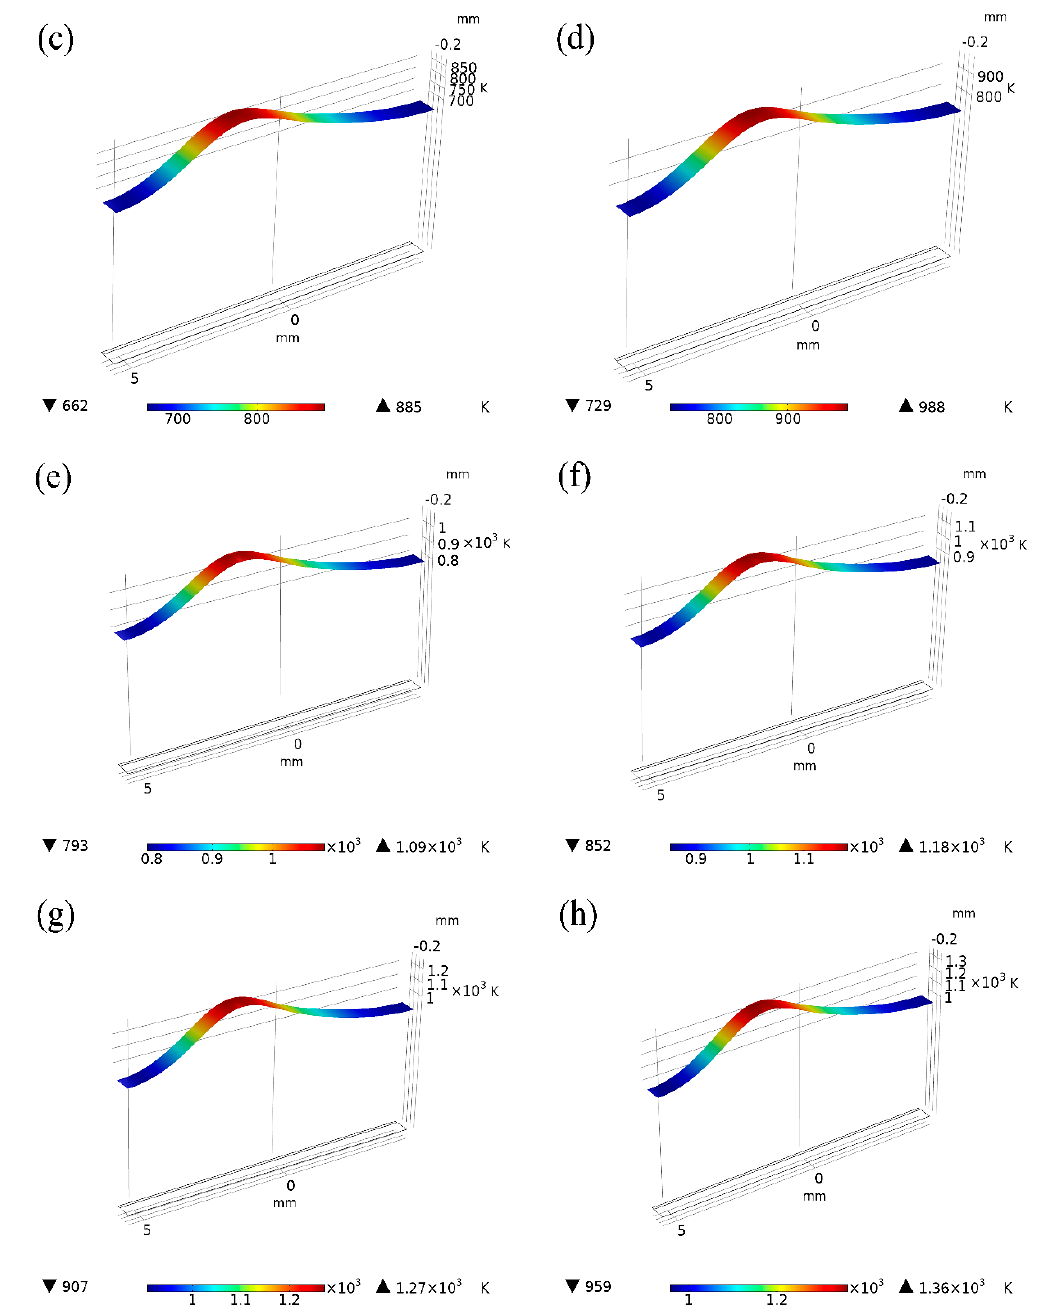
Figure 11. Temperature field of different power under the same section ( a ) 15 W, ( b ) 20 W, ( c ) 25 W, ( d ) 30 W, ( e ) 35 W, ( f ) 40 W, ( g ) 45 W, ( h ) 50 W. ( d ) 30 W, ( e ) 35 W, ( f ) 40 W, ( g ) 45 W, ( h ) 50